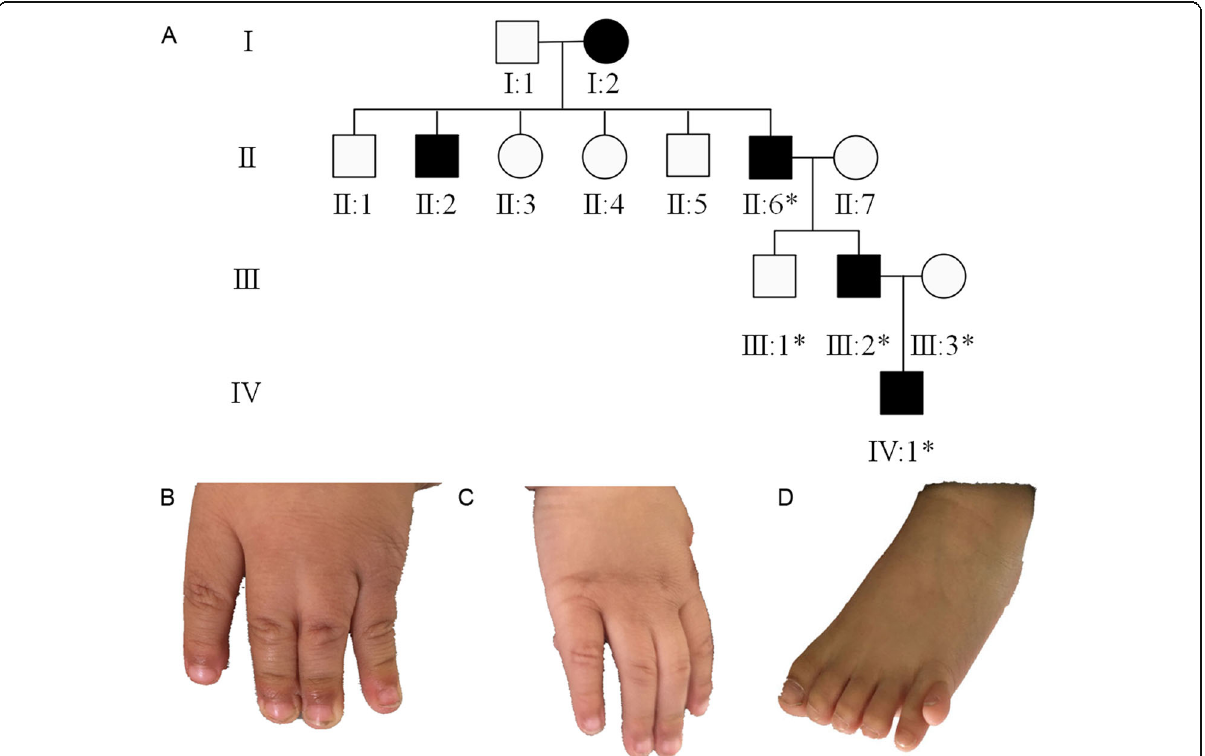
Fig. 1 The clinical phenotype. a . Family tree of the studied individuals (the individuals included in this study are specified by asterisks). Both hands of the proband ’ s grandfather were classified as post-axial polydactyly type B (individual II:6). The father ’ s left hand was classified as post-axial polydactyly type B (individual III:2). The patient ’ s right hand was classified as post-axial polydactyly, and his left hand had cutaneous webbing between the 3rd and 4th fingers; his left foot had a well-formed digit on the fibular aspect (individual IV:1) ( b , c and d